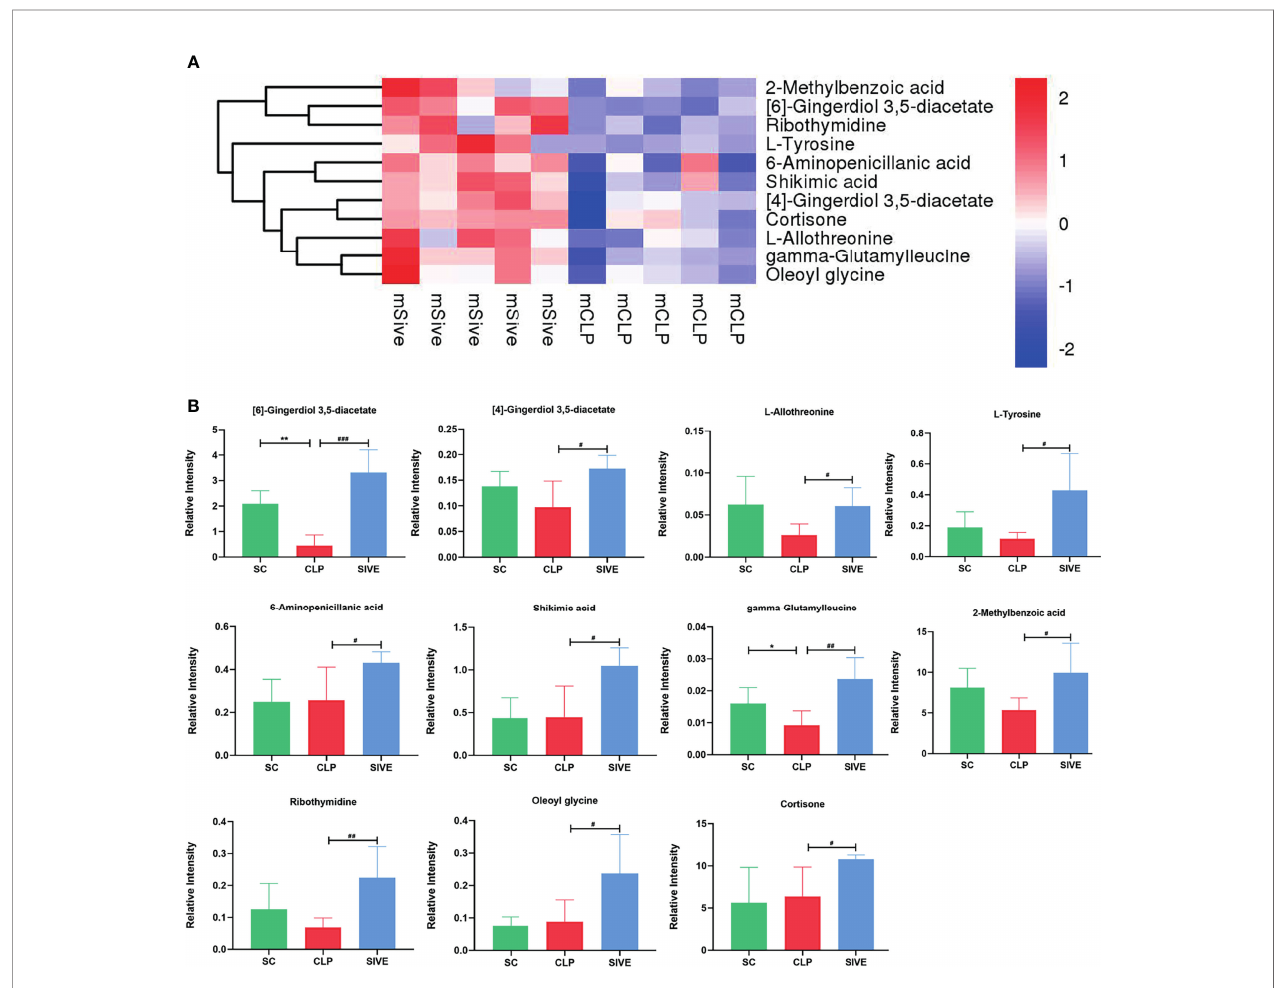
FIGURE 5 | Differential metabolites between the Sive and CLP groups. (A) Heatmap of hierarchical clustering analysis based on metabolite z-normalized abundances. (B) Relative intensities of metabolites in the experimental groups. * Compared with the SC group; # compared with the CLP group; * , # P <0.05; ** , ## P <0.01; ### P